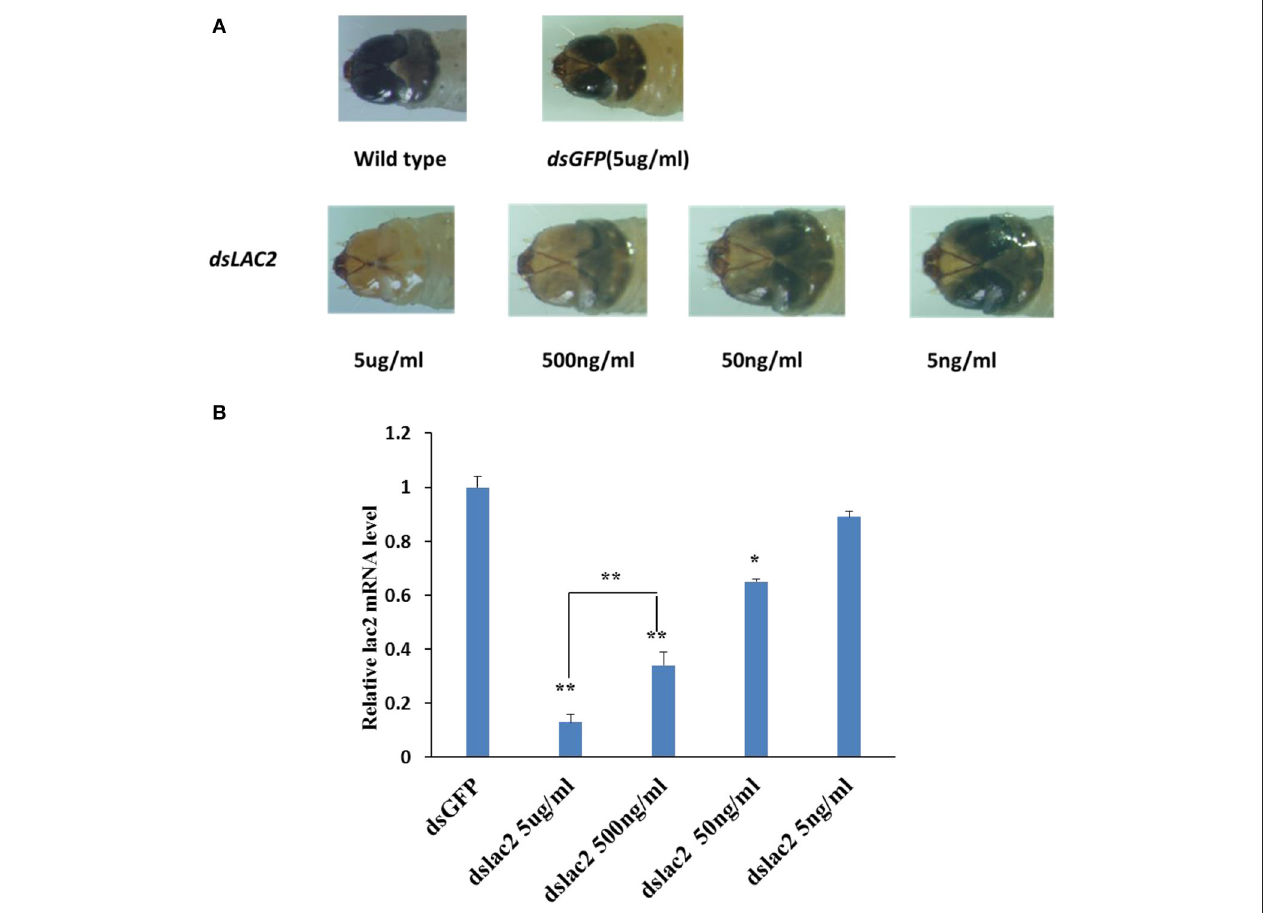
FIGURE 10 | Effect of dsRNA does on feeding RNAi efficiency. (A) Lac2 RNAi with various doses of dsRNA. Feeding 500ng/ml or more of dsRNA induced easily identifiable pigmentation defects in lac2 RNAi. (B) Relative expression level of lac2 by various doses of Lac2 dsRNA. Data were analyzed using Student’s t -test (** p < 0.01, * p <